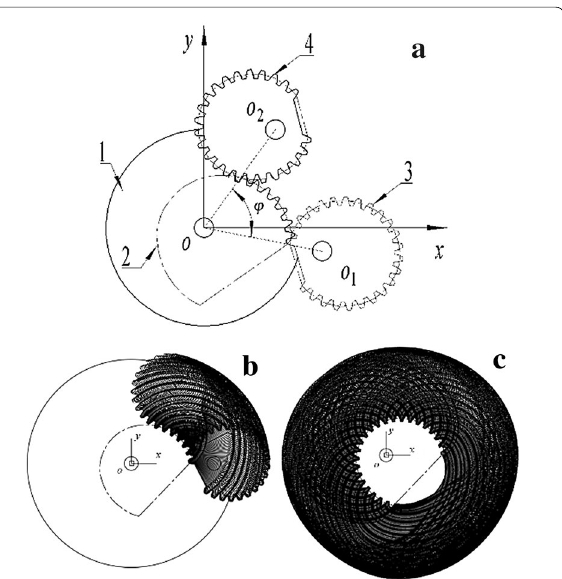
Figure 14 Gear processing method: a Schematic diagram: 1. Benchmark gear billet, 2. Processed gear pitch curve, 3. Tool gear in the initial position, 4. Moving tool gear; b Process diagram; c Finished diagram